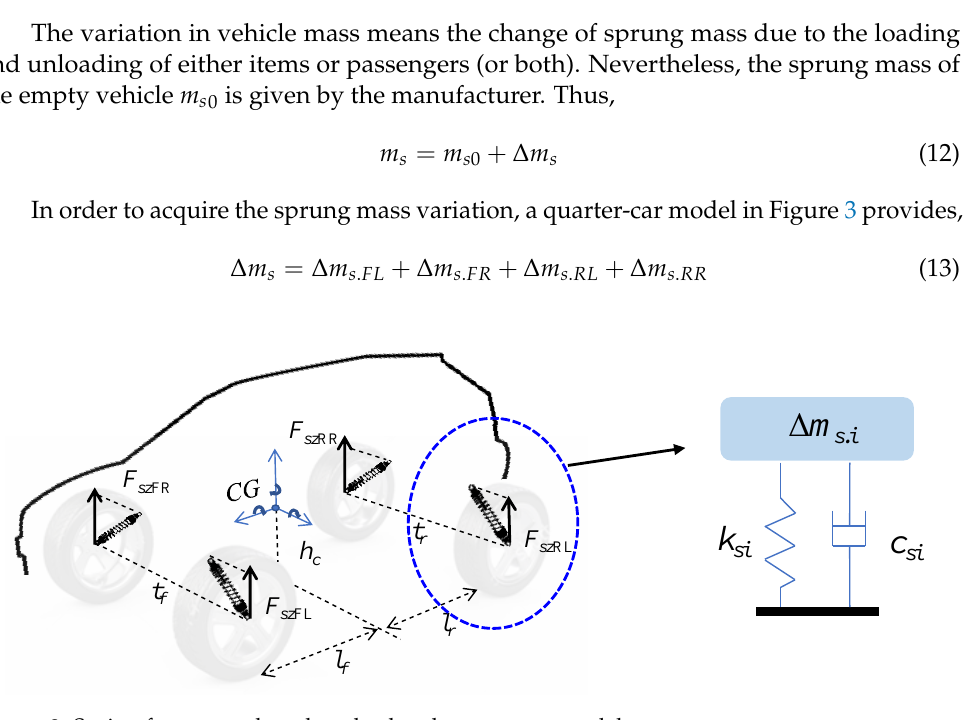
Figure 3. Spring forces acted on the wheel and quarter-car model. The suspension springs are varied by the corresponding sprung mass on each side.